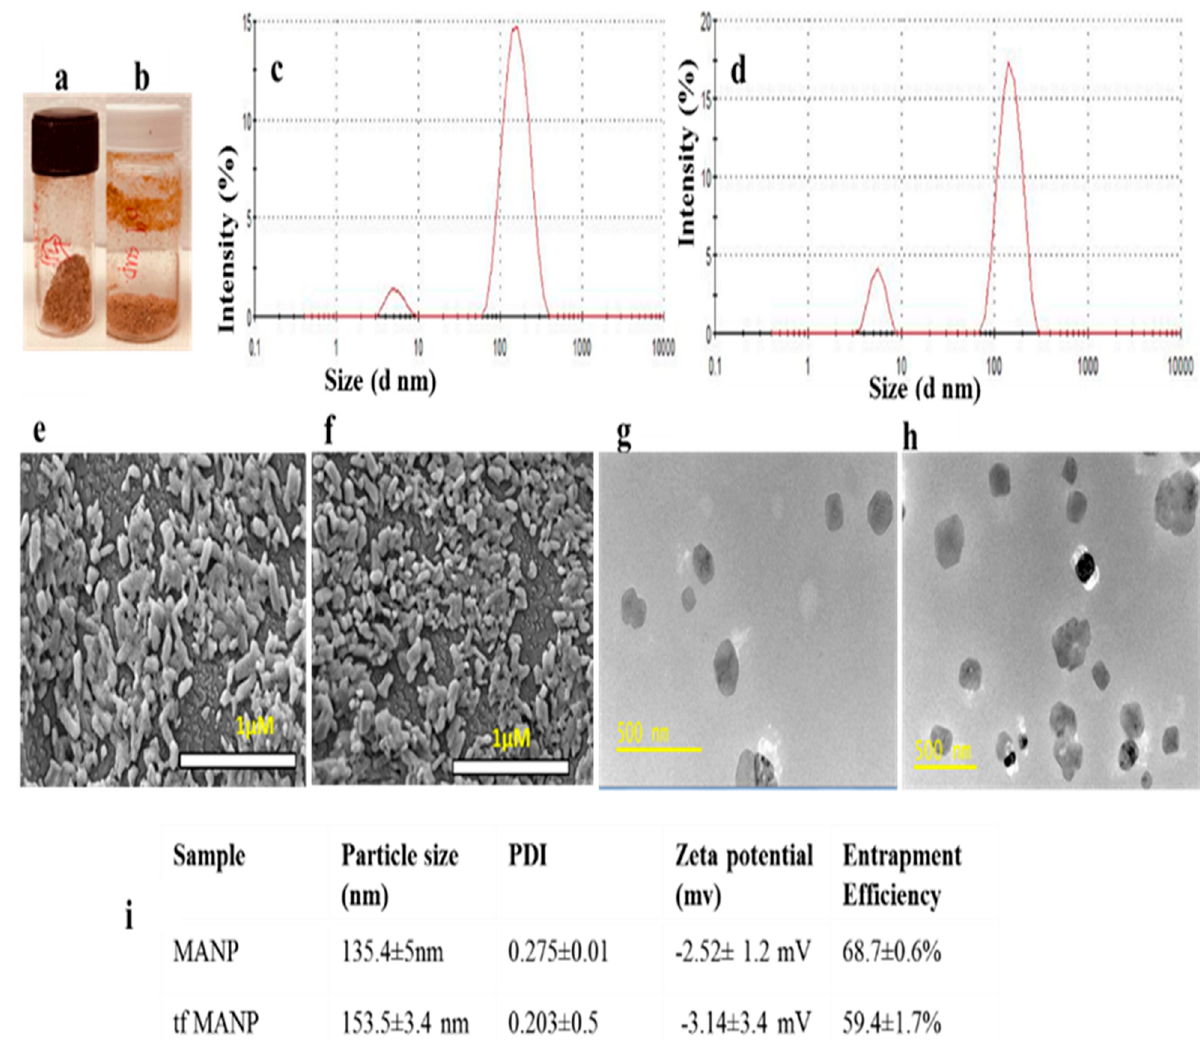
Figure 2. Characterization of the physical and chemical properties of MANP and tfMANP. Freeze- dried sample of ( a ) MANP and ( b ) tfMANP; Particle size of ( c ) MANP and ( d ) tfMANP; Representa- tive SEM images for ( e ) MANP (magnification =25,000 × ) and ( f ) tfMANP (magnification = 30,000 × ). Representative TEM images for ( g ) MANP (magnification = 26,000×) and ( h ) tfMANP (magnification = 26,000×). ( i ) Particle size, PDI, zeta potential and Entrapment Efficiency Data expressed as mean ± SD ( n = 3), statistical significance ( p < 0.05), PDI: Polydispersity Index.